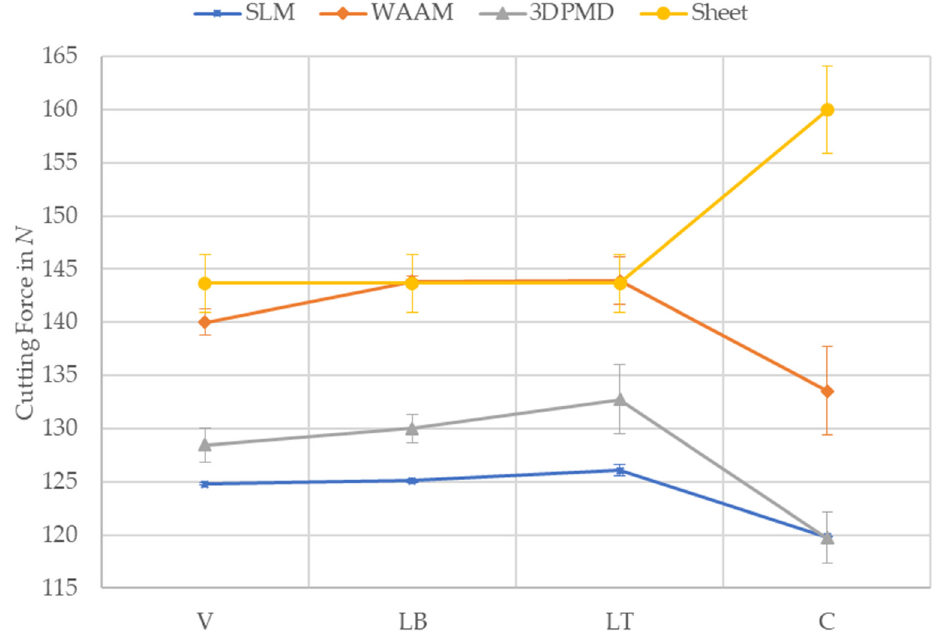
Figure 13. Mean milling force in the steady state area.